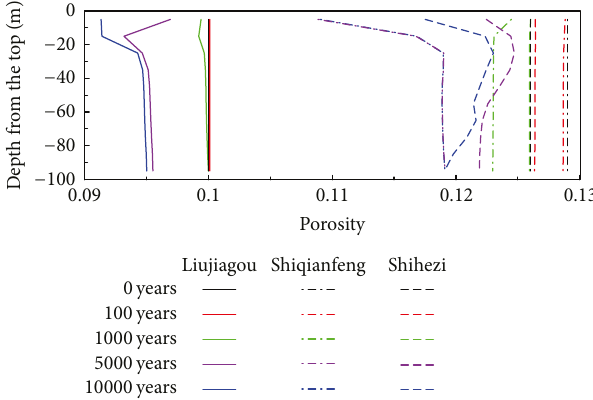
Figure 12: The vertical distributions of porosity changes in CO 2 bearing zone of the three formations at different